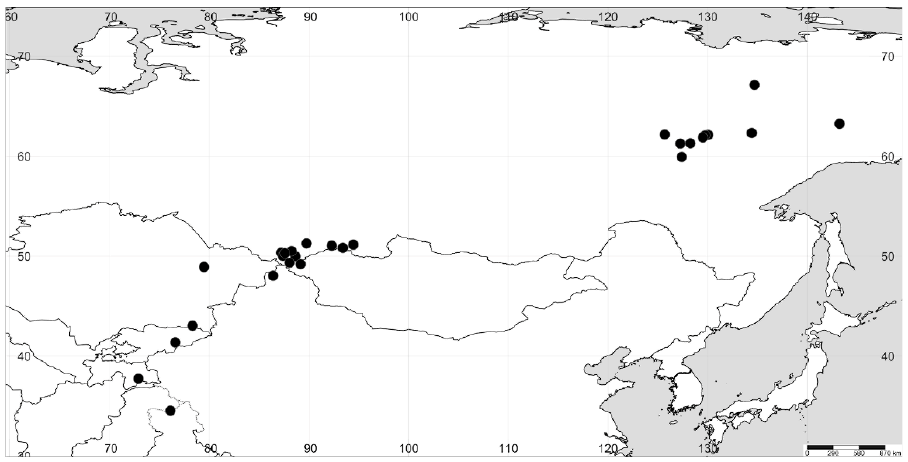
Figure 4. The distribution of A. sphaerosperma .